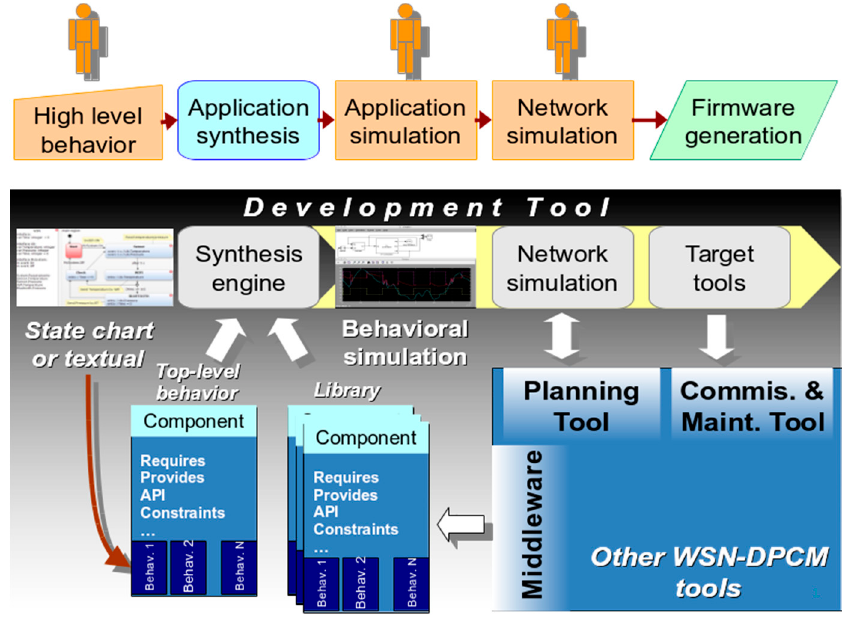
Figure 10. Main stages of semi-automated Development Tool flow.